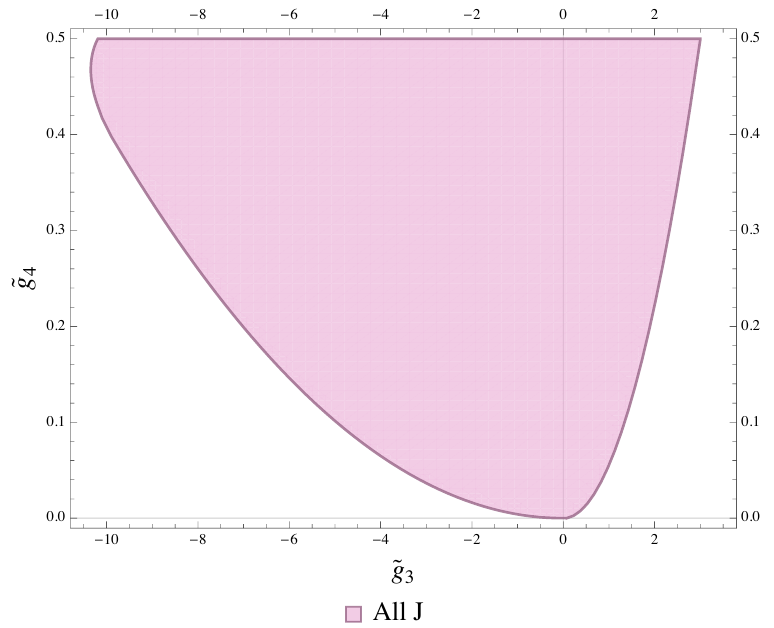
Figure 8. The (˜ g 3 , ˜ g 4 ) allowed region. Numerics were performed at n = 10 Mandelstam order and J = 0 , 2 , . . . , 40 . One can see that g 3 may take-on negative values, while g 4 is positive. Boundaries appear smooth except for two kinks at ( − 10 . 19 , 0 . 5) and (3 , 0 . 5)